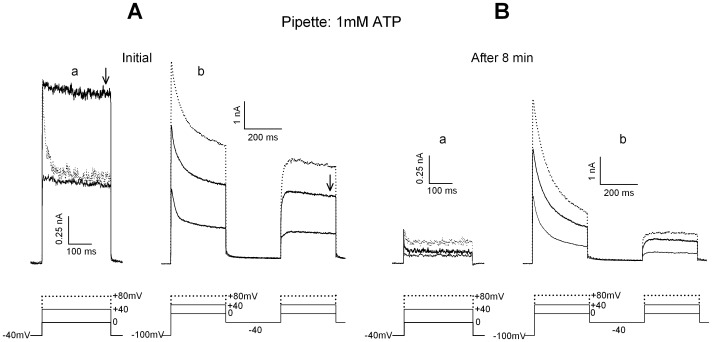
Decomposition of the effects of long-lasting recording with 1 mM ATP-patch clamp-pipettes.
A. Initial tracings of the currents evoked in a hair cell by steps to 0/+80 mV (only three steps illustrated for clarity) from a holding potential of −40 mV (a) and by the same protocol after a 1 sec conditioning at −100 mV (b). In (b) the current families are evoked twice: immediately following conditioning (IA inactivation removed) and after a sojourn at −40 mV sufficient to maintain full IA inactivation (but with little effect on the removal of IKD inactivation by the previous conditioning at −100 mV). The difference-currents between the two episodes dissect the pure IA at each test potential (see text and Martini et al. [1], for details). Arrows indicate the IKD amplitude used to evaluate the effect of inactivation removal. B. Same protocols as in A, applied in the same cell 8 min later. Note the drastic decrease in IKD amplitude and the monotonic increase in the I–V curves (as opposed to panel A). IA peak amplitude, after appropriate dissection, remains constant at each test potential, the apparent decrease being exclusively due to the IKD component.